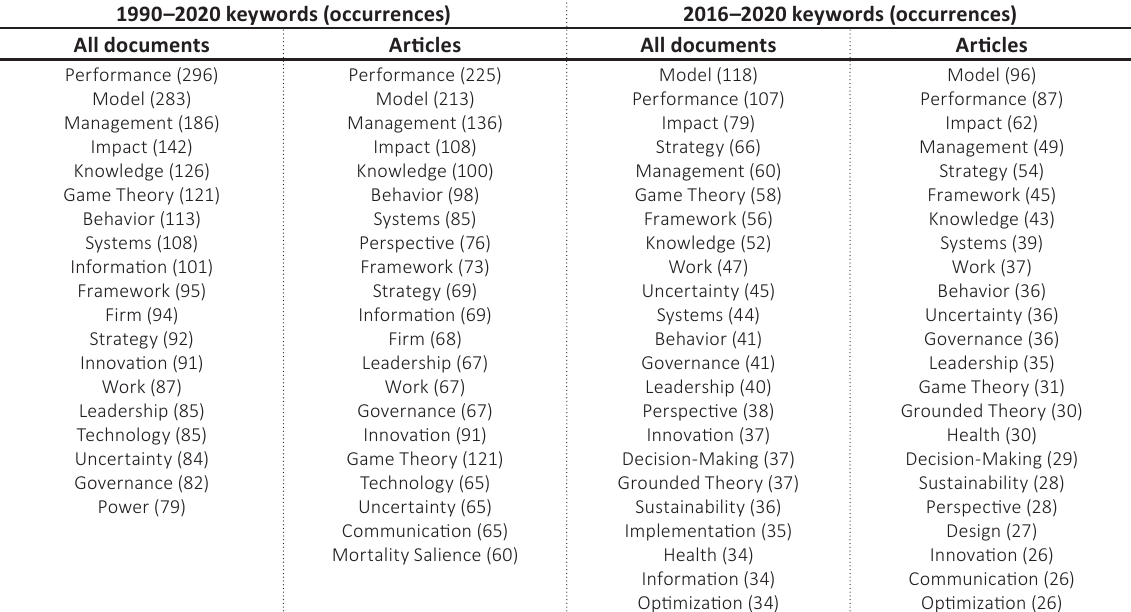
Table 2. The most-cited keywords 1990–2020 keywords